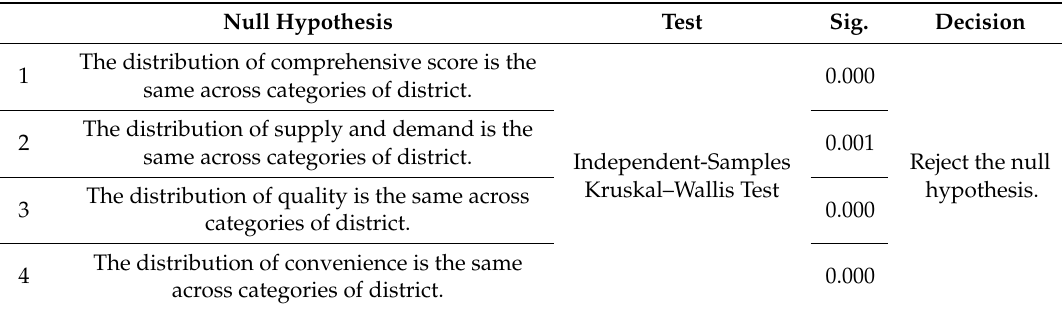
Table 3. The summary of the four Kruskal–Wallis independent sample test results.